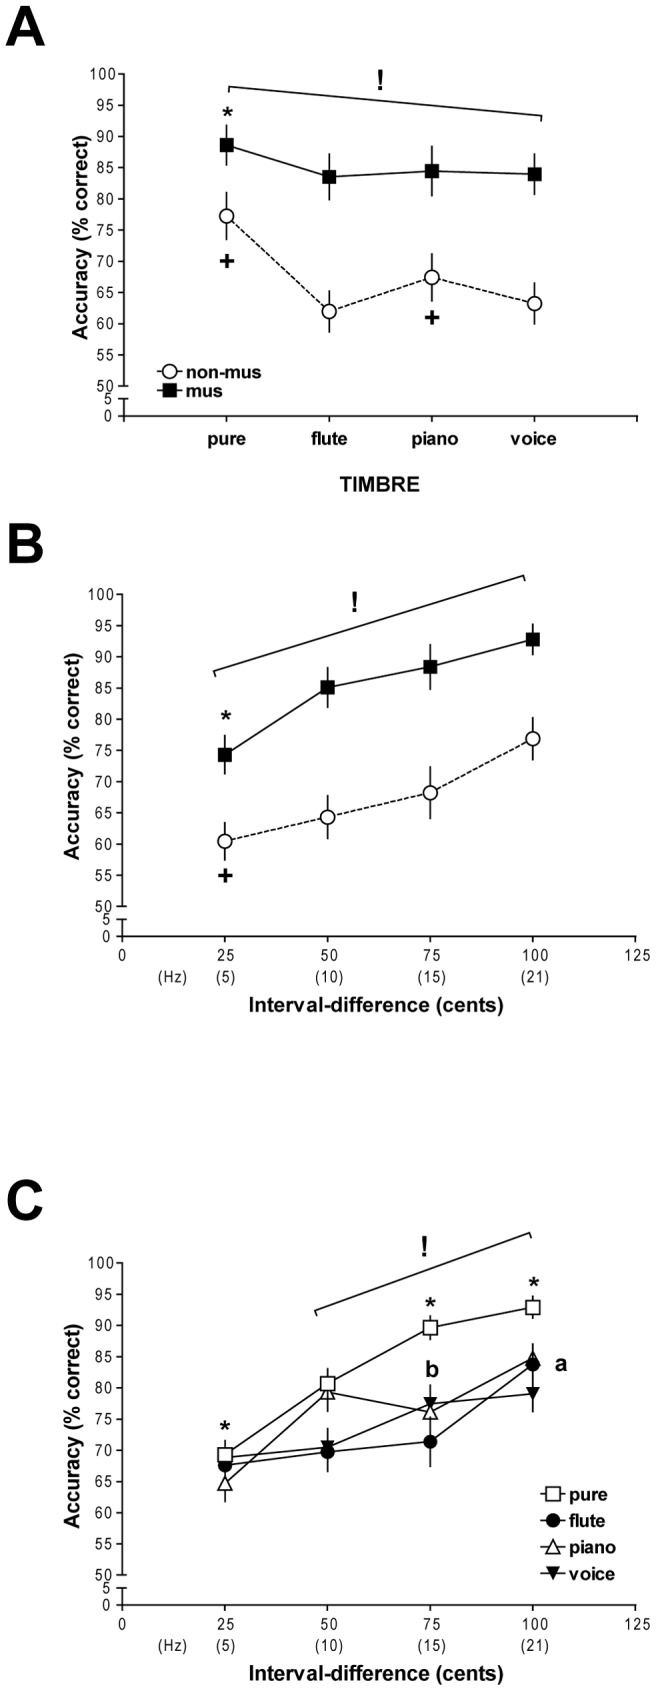
Interval-discrimination accuracy.(A) Mean ± SEM percent-correct scores of musicians and non-musicians for interval discrimination, across the four timbre types and collapsed across all interval-differences. Musicians performed more accurately than non-musicians across all timbres (indicated by!, p<0.001), but were marginally most accurate with pure-tone intervals (denoted by *, p<0.06). Non-musicians showed more accurate interval discrimination with pure and piano tones than with the other two timbres (marked by +, p<0.05). (B) Mean ± SEM percent-correct scores of musicians and non-musicians for each interval-difference collapsed across timbre types. Musicians were more accurate than non-musicians overall (marked by!, p<0.001). Both musicians (denoted by *, p<0.001) and non-musicians (indicated by +, p<0.05) displayed the least accuracy at the 25-cent interval-difference. (C) Mean ± SEM percent-correct scores for each timbre type at each interval-difference, averaged across both groups. All subjects discriminated pure-tone intervals more accurately than flute- and voice-tone intervals at all interval-differences except 25 cents (shown by!, p<0.001), and better than piano-tone intervals at all interval-differences except 50 cents (marked with *, p<0.06). Flute-tone discrimination only improved at 100 cents (shown by a, p<0.001), while voice-tone performance significantly improved at interval-differences of 75 cents and higher (indicated by b, p<0.01).